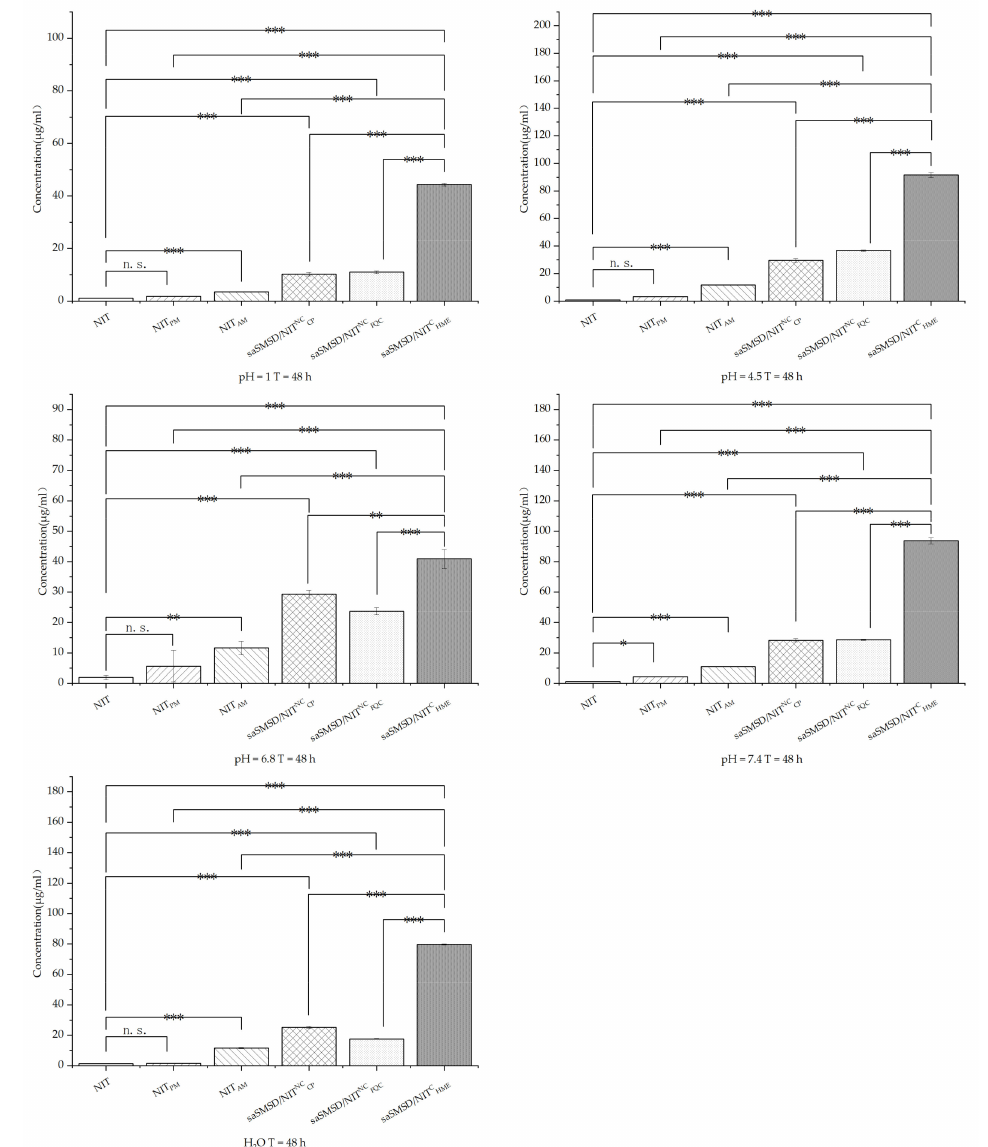
Figure 9. Solubility of samples in different solutions (H 2 O, 0.1 mol/L HCl and PBS (pH 4.5, 6.8, 7.5)) at 48 h; * p < 0.05, ** p < 0.01, *** p < 0.001, n. s., no significant difference. Standard deviation expressed by error bars ( n =